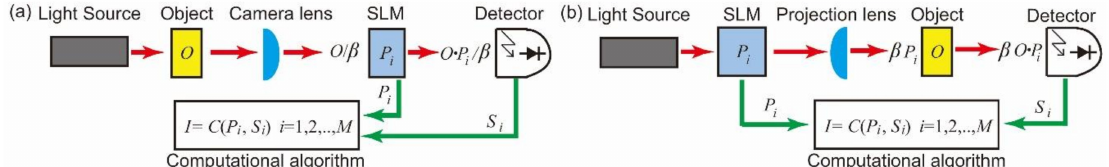
Figure 1. Schematics of two imaging architectures: ( a ) In single-pixel imaging, the object is first illuminated by the light source, then imaged by a camera lens onto the focal plane, where a spatial light modulator (SLM) is placed. The SLM modulates the image with different masks, and the reflected or transmitted light intensities are measured by a single-pixel detector. A computational algorithm uses knowledge of the masks. along with their corresponding measurements, to reconstruct an image of the object; ( b ) in ghost imaging, the object is illuminated by the structured light distribution generated from different masks on an SLM, and the reflected or transmitted light intensities are then measured by a single-pixel detector. A computational algorithm uses knowledge of the masks along, with their corresponding measurements, to reconstruct an image of the